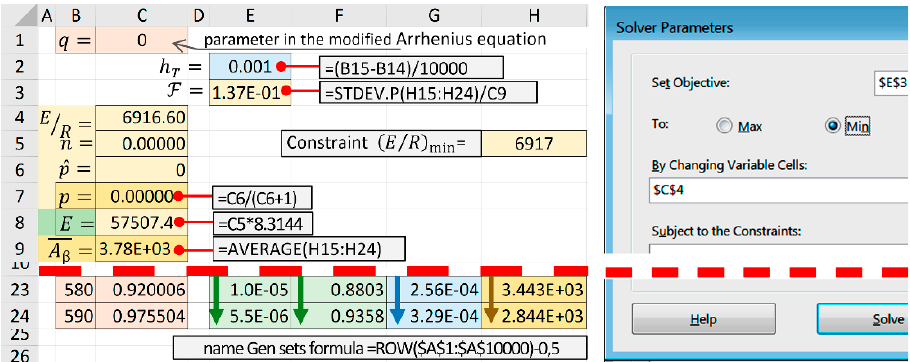
Figure 4. MS Excel worksheet screenshot (after executed the Solver add-in) and the Solver Parame- ters panel.